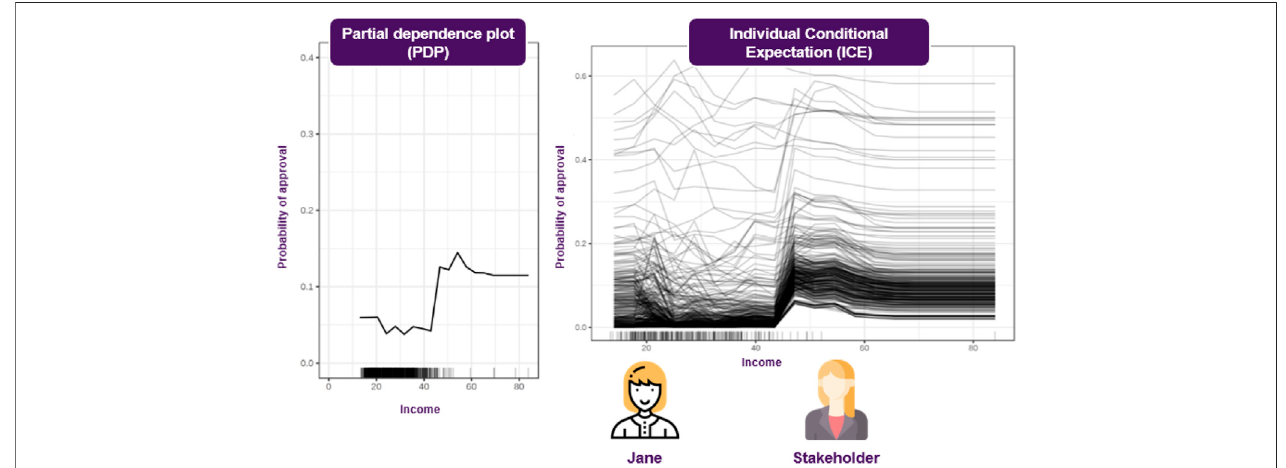
FIGURE 7 | Visualizations can facilitate understanding the model ’ s reasoning, both on an instance and a global level. Most of these approaches make a set of assumptions, so choosing the appropriate one depends on the application.